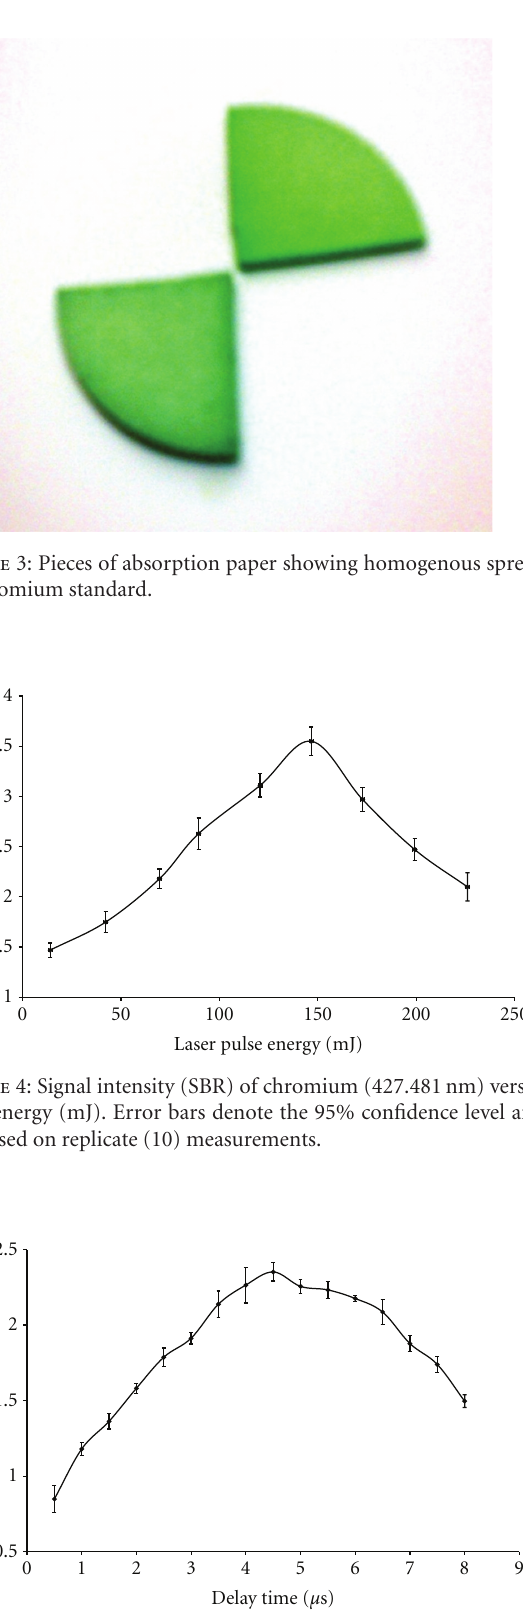
Figure 5: Signal intensity (SBR) versus delay time for chromium standard at 427.481 nm. Error bars denote the 95% confidence level and are based on replicate (10)